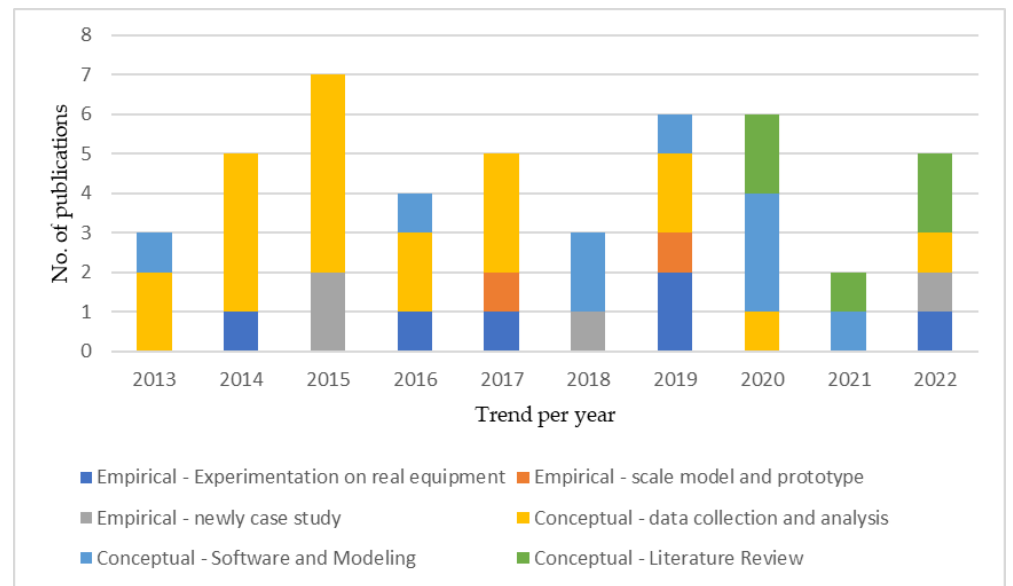
Figure 8. Sub-category trends per year.